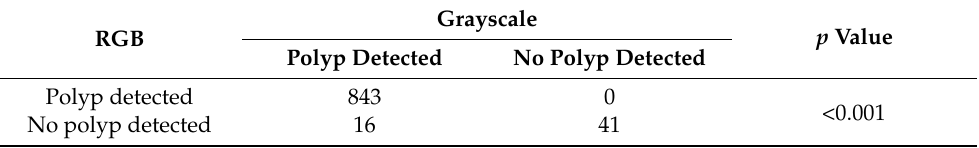
Table 7. Comparison of polyp detection between RGB and grayscale images with CGMH- WLtesting dataset.